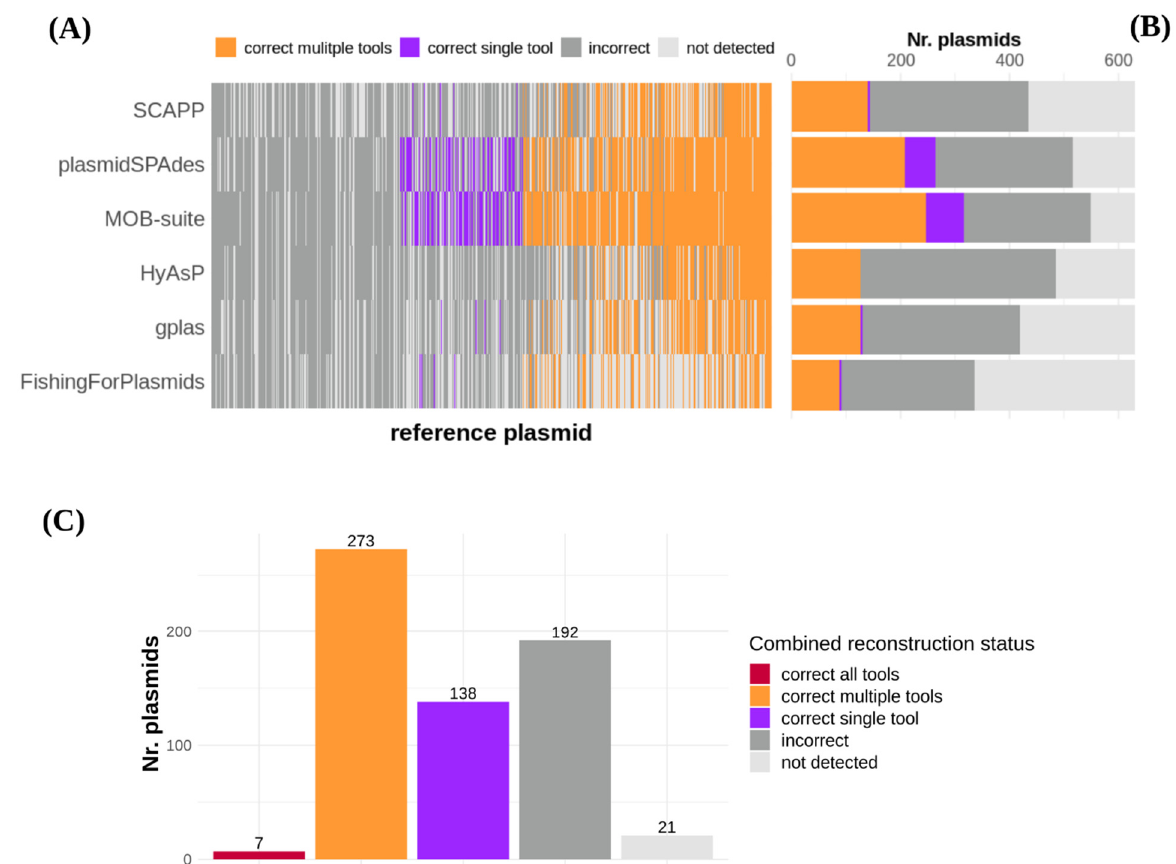
Figure 3. ( A ) Reconstruction performance of each tool for all reference plasmids. Reference plasmids have been ordered according to the number of tools by which they were correctly reconstructed, from low (left; reconstructed by 0/6 tools) to high (right; reconstructed by 6/6 tools). Plasmids that were reconstructed with an F1-score ≥ 0.95, were considered as correct reconstructions. Plasmids for which no contig was included in the predictions were considered as ‘not-detected’. ( B ) Absolute count of all reconstruction status achieved by each tool. ( C ) Absolute count of reconstruction categories when combining predictions from all tools.